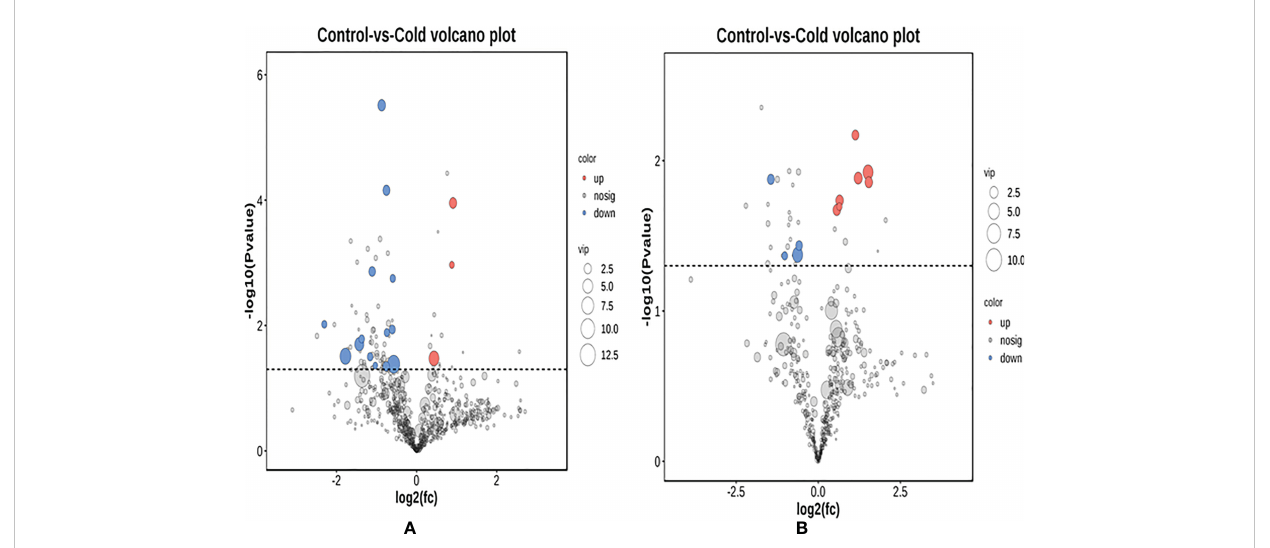
FIGURE 6 Volcano plot of juvenile Trachinotus ovatus under low-temperature intestinal metabolites. (A) Positive ion mode, A red spot represents a predominance of down-regulation metabolite. A blue spot represents a predominance of up-regulation metabolite. (B) Negative ion